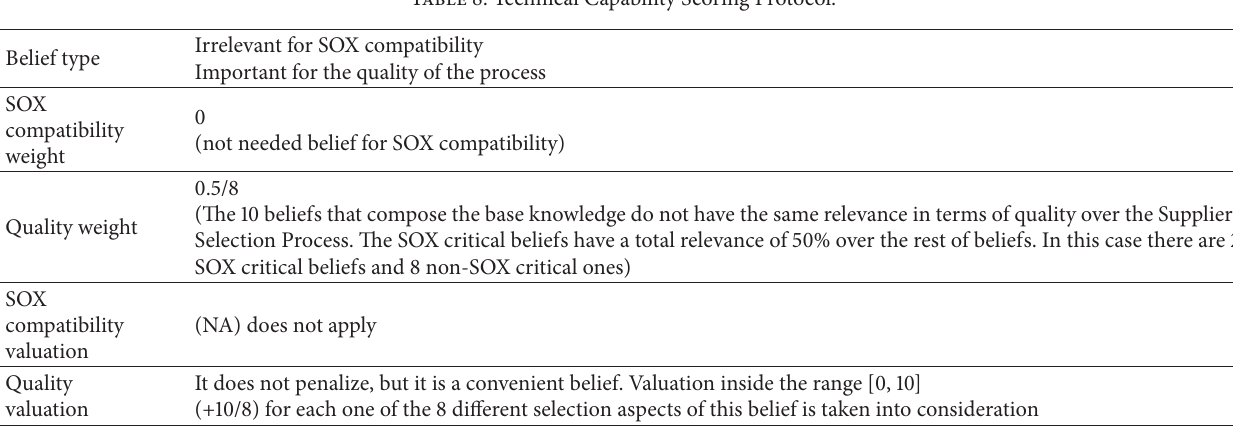
Table 8: Technical Capability Scoring